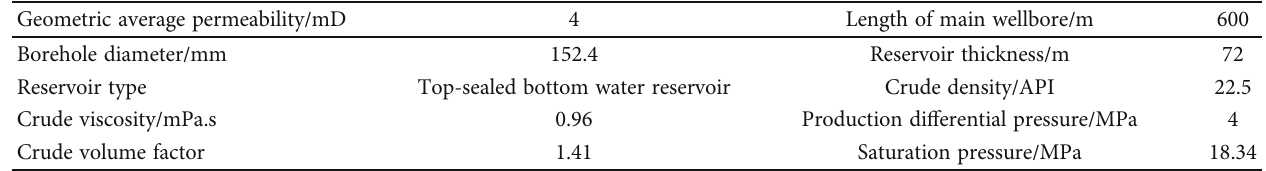
Table 2: Basic parameters of one fi shbone well.